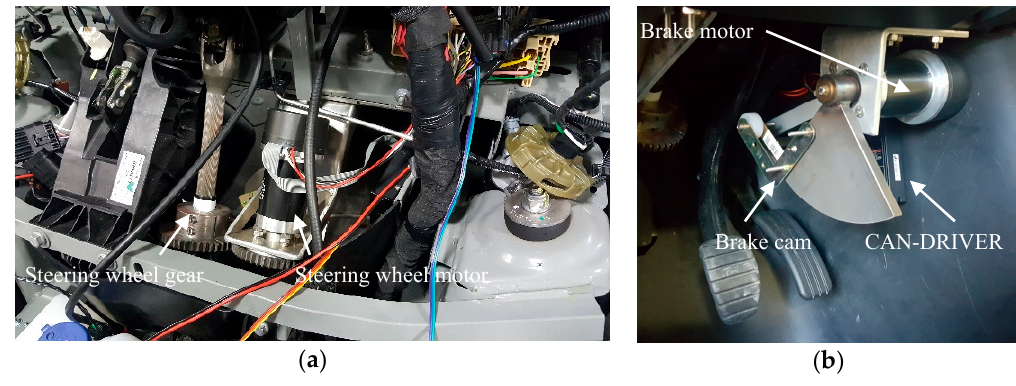
Figure 4. Actuation system: ( a ) steering wheel and ( b ) breaking pedal.